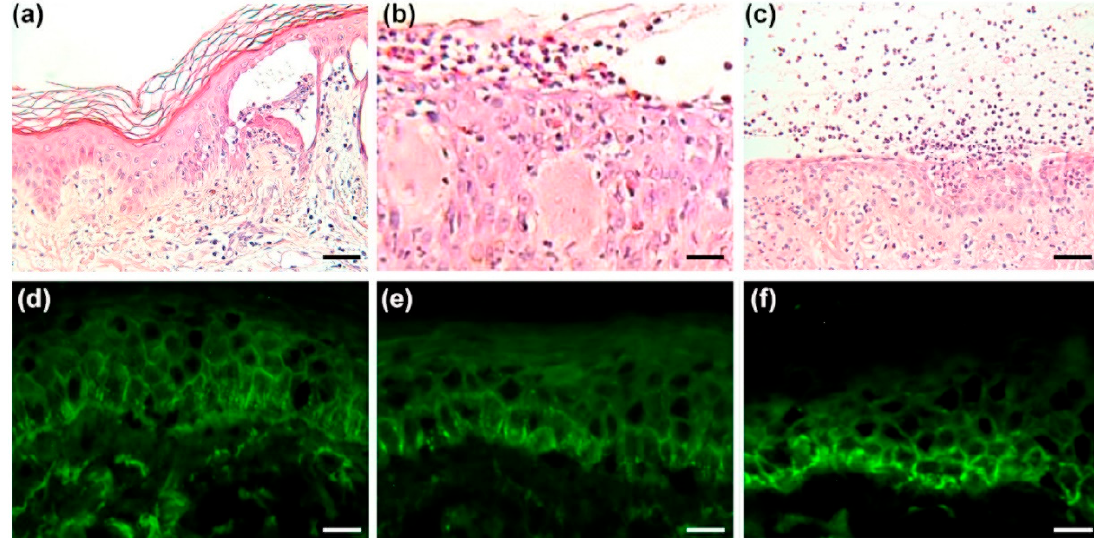
Figure 2. Features of histopathology and direct immunofluorescence in patients with IgG/IgA pem- phigus . ( a ) Intra-epidermal blisters with scanty acantholysis and apoptotic keratinocytes were found (Scale bar = 50 μ m). ( b ) Infiltration of eosinophils and dermal edema was noted in some cases (Scale bar = 25 μ m). ( c ) Infiltration of neutrophils was sometimes prominent (Scale bar = 50 μ m). ( d ) Positive IgG deposition in the intercellular space of the epidermis was shown in direct immunofluorescence (Scale bar = 50 μ m). ( e , f ) Positive IgA depositions at lower levels of the epidermal intercellular space were demonstrated by direct immunofluorescence (Scale bar = 50 μ m). Table 2. Results of histopathology and direct immunofluorescence.